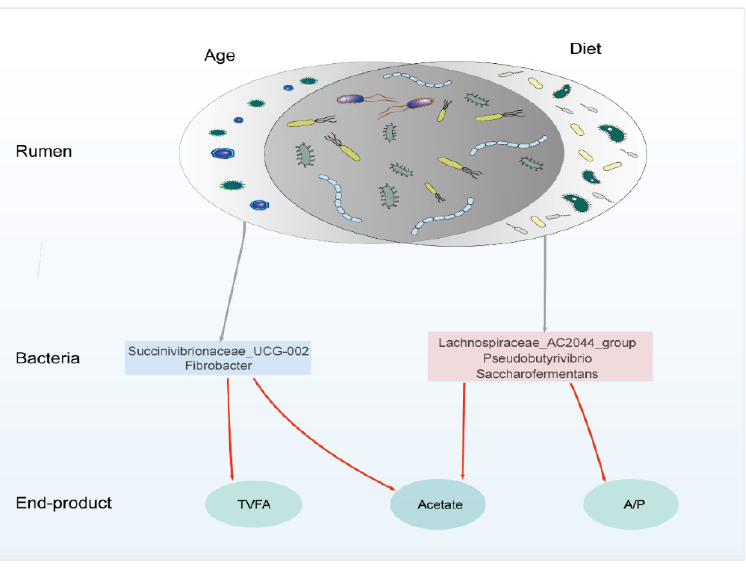
Figure 5. Diagram of the proposed mechanism for age and diet influence on the rumen function. All these bacteria were at the genus level and significantly correlated with TVFA, acetate, and A/P (r > 0.50, p < 0.01). Succinivibrionaceae_UCG-002 and Fibrobacter were correlated with age (r > 0.60, p < 0.01). Lachnospiraceae_AC2044_group, Pseudobutyrivibrio, and Saccharofermentans have a Spear- man’s correlation coefficient value >0.80 with diet NDF and <−0.80 with diet CP and starch ( p < 0.01). The red line indicates that the bacteria positively correlate with TVFA, acetate, and A/P. Our results give the target bacteria to regulate the rumen function based on different age or diet conditions, promising to provide a theoretical basis for the precision feeding of dairy cattle. TVFA: total volatile fatty acid, CP: crude protein, NDF: neutral detergent fiber, A/P: acetate to propionate ratio.